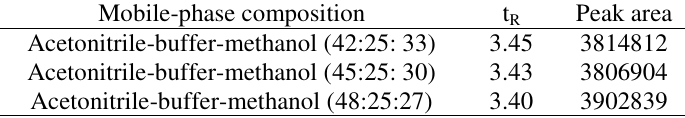
Table 9. The influence of small changes in mobile-phase composition (Method Robustness)